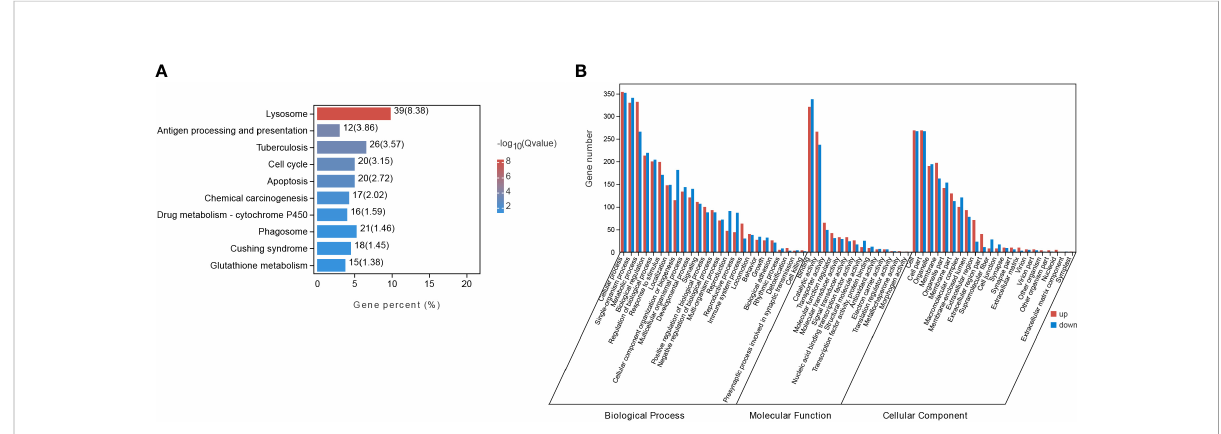
FIGURE 3 DEGs enrichment analysis in starved and fed CoTS. (A) Top 10 of KEGG enriched pathways. (B) Histogram of GO enriched genes in